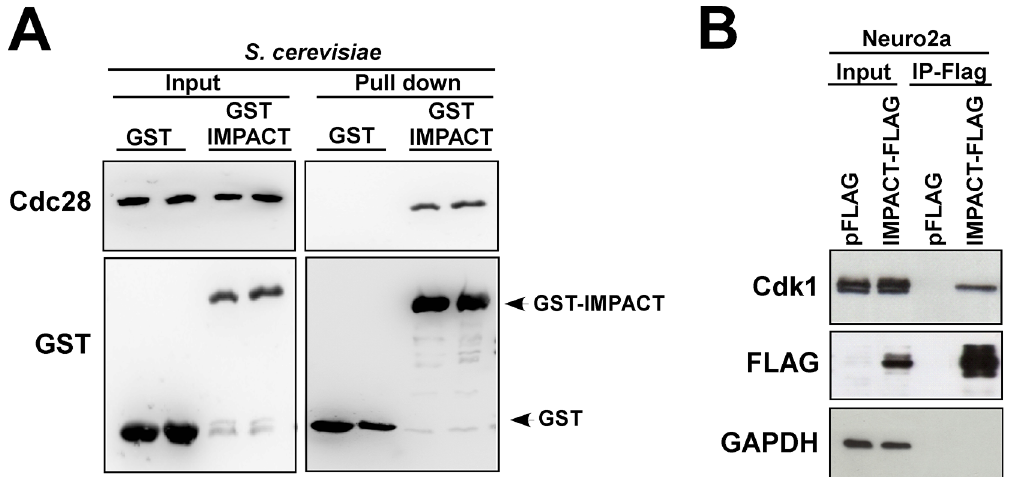
Fig 11. Mammalian IMPACT forms a complex with Cdc28 and CDK1. (A) Mammalian IMPACT expressed in yeast precipitates Cdc28. Two different transformants of yih1 Δ strain (BY4741) expressing either GST-IMPACT or GST alone from a galactose inducible promoter were grown to log phase in SGal. WCEs were prepared and equivalent amounts of protein (1 mg) were subjected to GST-pull-down assays. The precipitated complexes were analyzed by immunoblot for the indicated proteins. The input lanes (left-panel) contained 4% of the WCEs used in the assay. (B) CDK1 co-precipitates with Flag-tagged IMPACT in N2a cells. Undifferentiated mouse N2a cells were transfected with a plasmid expressing IMPACT fused to Flag or with the vector alone (pFLAG). Cell lysates were cleared with protein-A agarose and subjected to immunoprecipitation with anti-Flag antibodies (M2-Flag-Resin). All the precipitated material and 1% of the input material were subjected to immunoblot to detect Flag-IMPACT, CDK1, and GAPDH as negative control.